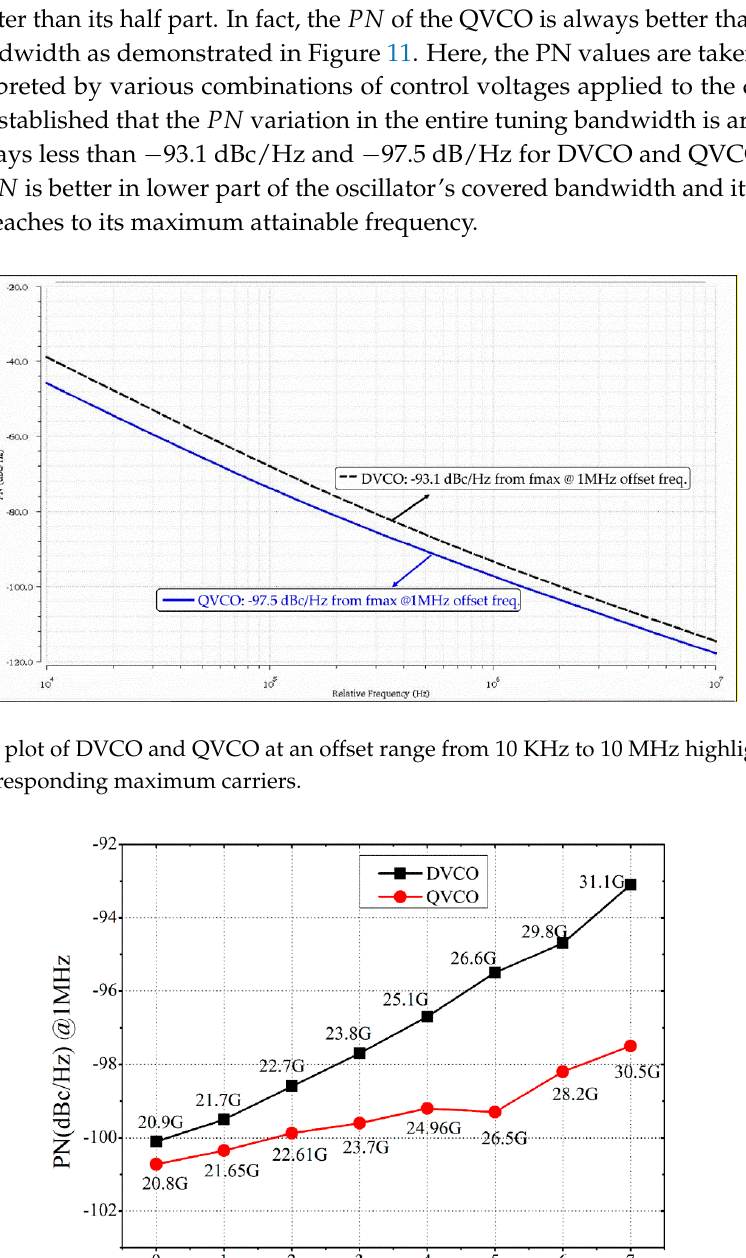
Figure 9. A simplified schematic of the superharmonically coupled Quadrature Voltage Controlled Oscillator (QVCO) with proposed wideband varactor circuits.